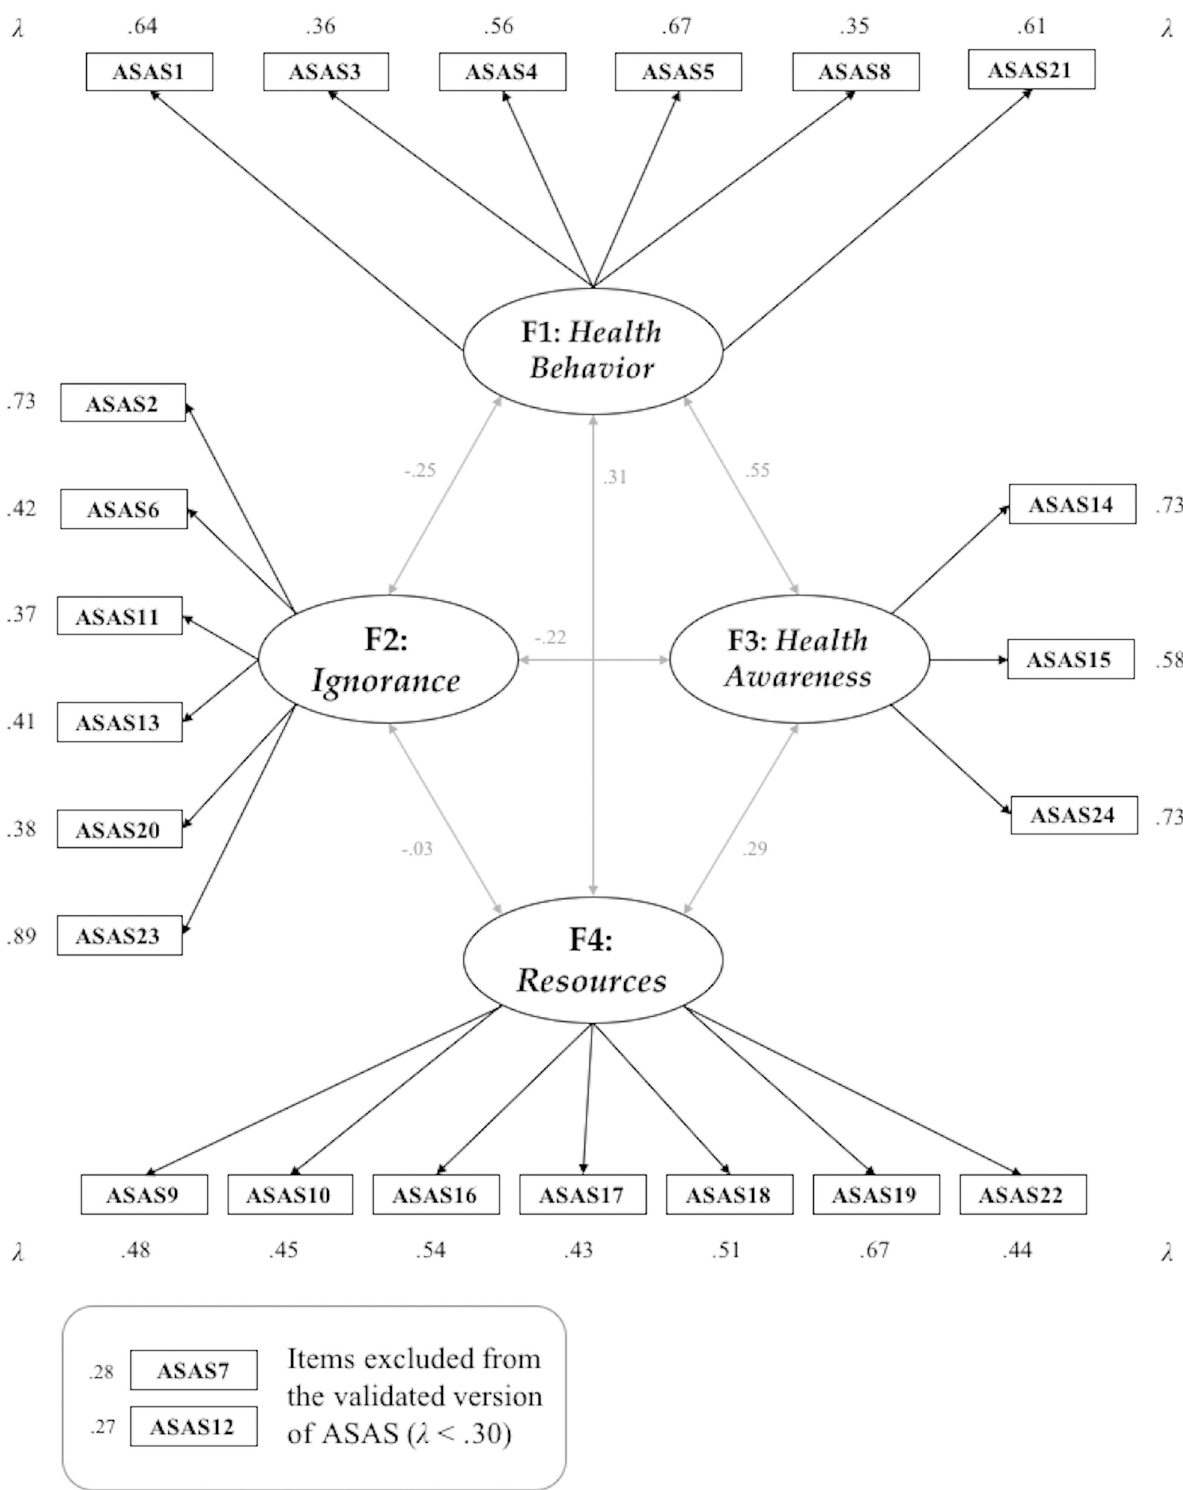
Fig 1. Standardized parameter estimates and factor correlations. Notes : All standardized estimates were p < .001; the numbers within squares represent the original numbers of the items in the ASAS (as shown in Table 4).